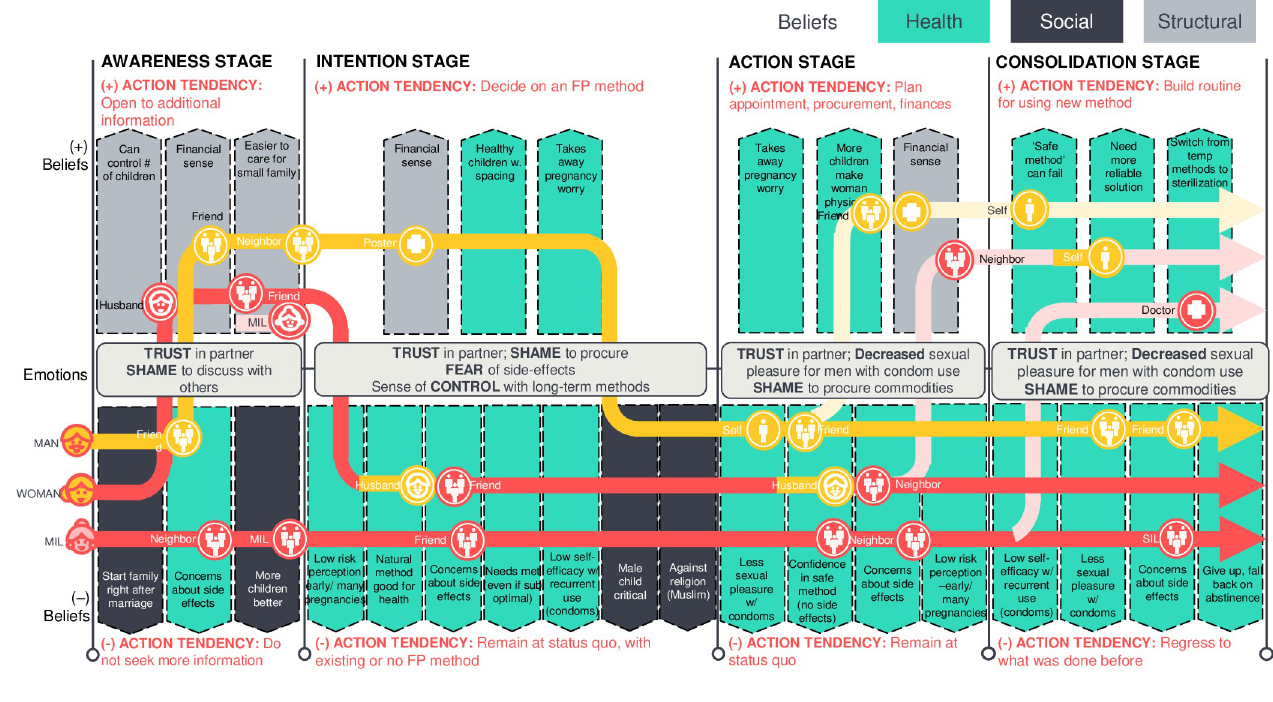
Fig 3. FP journey. Figure shows a summary of qualitative journey mapping outputs (n = 6 women, 6 husbands, 6 mother-in-law (MIL), 6 ASHA, and 6 friends/ family). The combined journey mapping analysis illustrates the different beliefs that either facilitate (+) or inhibit (-) progression to the next action tendency towards contraceptive use. Health beliefs are those about health risks to the mother and/or baby. Social beliefs include community norms and structural beliefs include anything related to family structure. At each action stage (awareness, intention, action, and consolidation) health, social, and structural beliefs determine whether a woman, husband, or mother-in-law (yellow and red lines) will seek more information, intend to use FP, use FP, and form FP habits. Influencers (circles) contribute to stakeholders’ beliefs at each stage.